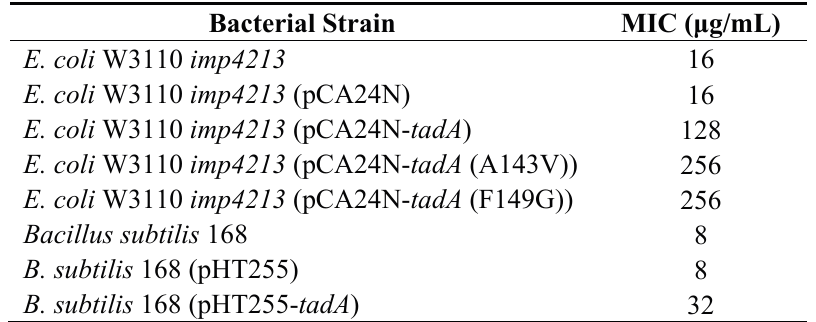
Table 2. Xanthorrhizol minimum inhibitory concentration s of wild-type and mutant tadA -overexpressing